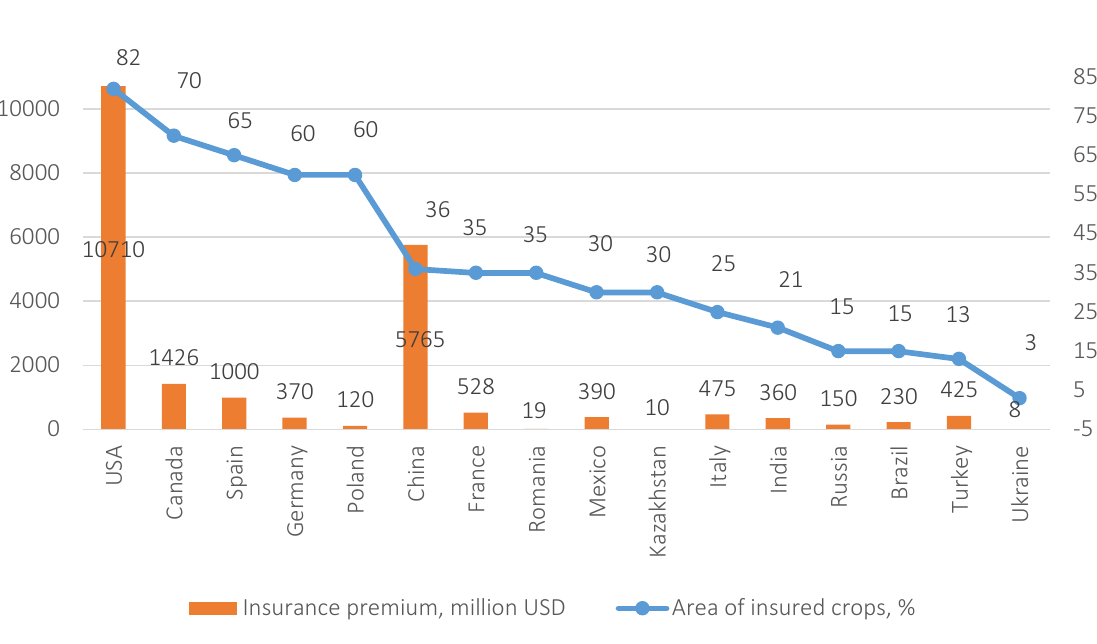
Figure 13. The world insurance market of agricultural crops in the context of the main indicators in 2017